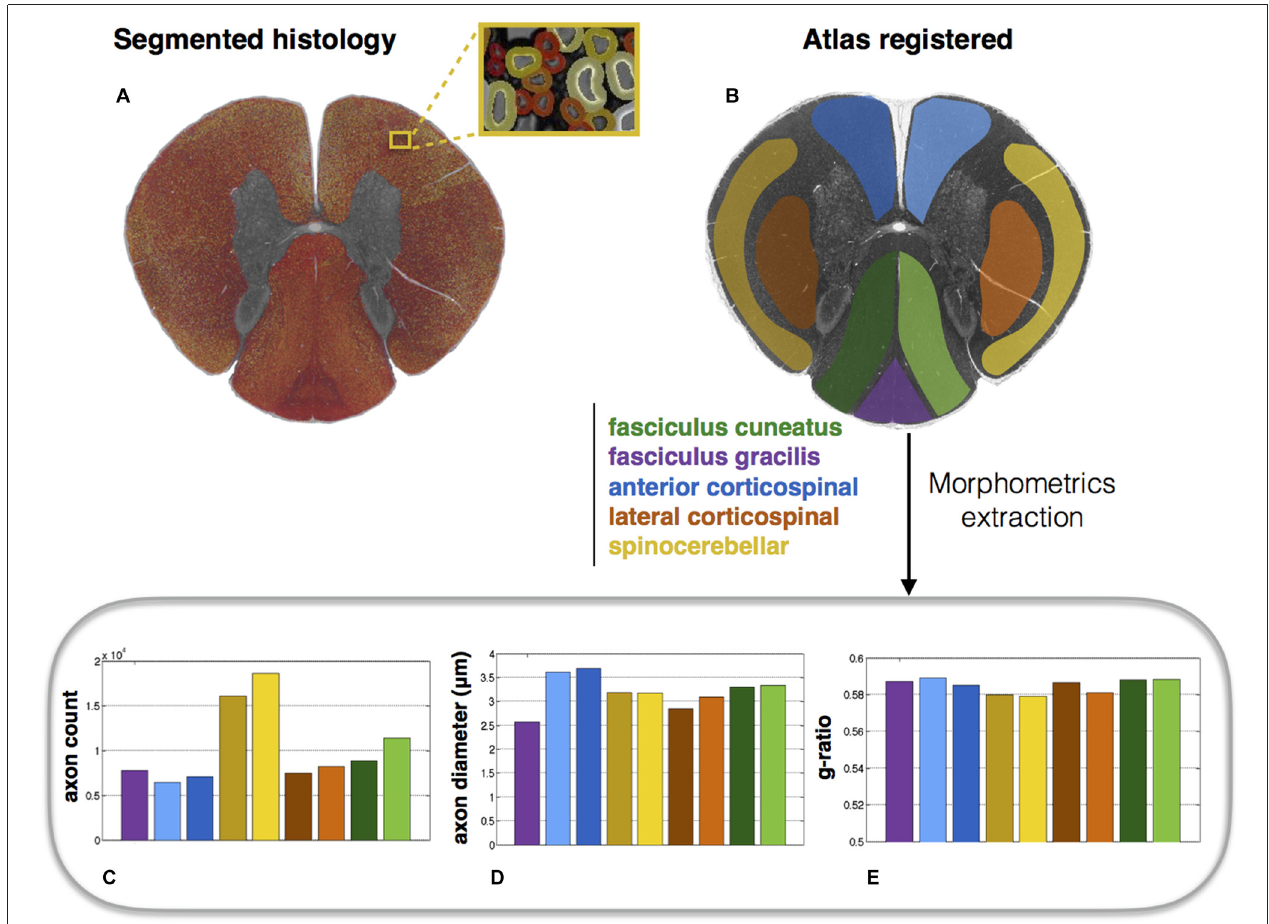
FIGURE 5 | Atlas-based morphometry from segmented images. (A) Segmented histology results. (B) Atlas of white matter tracts registered to the histology image. Morphometric statistics for each of the tracts are extracted: (C) Axon count; (D) Axon diameter (mean); (E) Myelin g-ratio. Note the slightly lower g-ratio compared to the expected values from the literature (about 0.7; Chomiak and Hu, 2009), which is likely due to the poor resolution of the optical microscope inducing an over-segmentation of the myelin